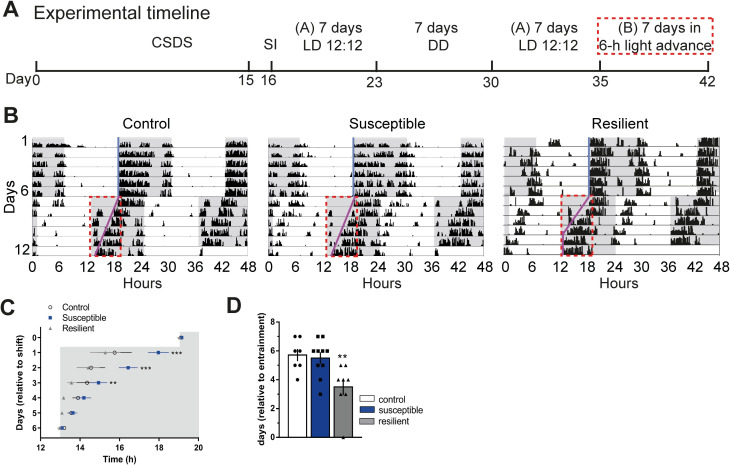
Susceptible or resilient mice exhibit different rates of photoentrainment.(A) Experimental timeline (A, normal light cycle: Lights ON: 07:00; Lights OFF: 19:00; B, new light cycle following 6 h advance: Lights ON: 13:00; Lights OFF: 01:00), red box denotes 6 h lights advance in new LD cycle. (B) Representative double-plotted actograms of activity before and after 6 h shift in LD cycle. Grey background indicating dark phase of the LD cycle. Light-blue and pink lines representing extended regression line derived by onset of activity under normal and new LD cycles, respectively. Dotted red lines outlining the data of activity onsets shown in (c). (C) Susceptible mice display significantly slower initial rate of photoentrainment in the new LD cycle (F2,25 = 10.81, P < 0.001) (D) Resilient mice took significantly less number of days to reentrained in the new LD cycle (F2,22 = 6.587, P < 0.05). N = 7–10 mice/group. Error bars: mean ± SEM. The raw data can be found in S5 Data. CSDS, chronic social defeat stress; DD, complete darkness; LD, light–dark; SI, social interaction.